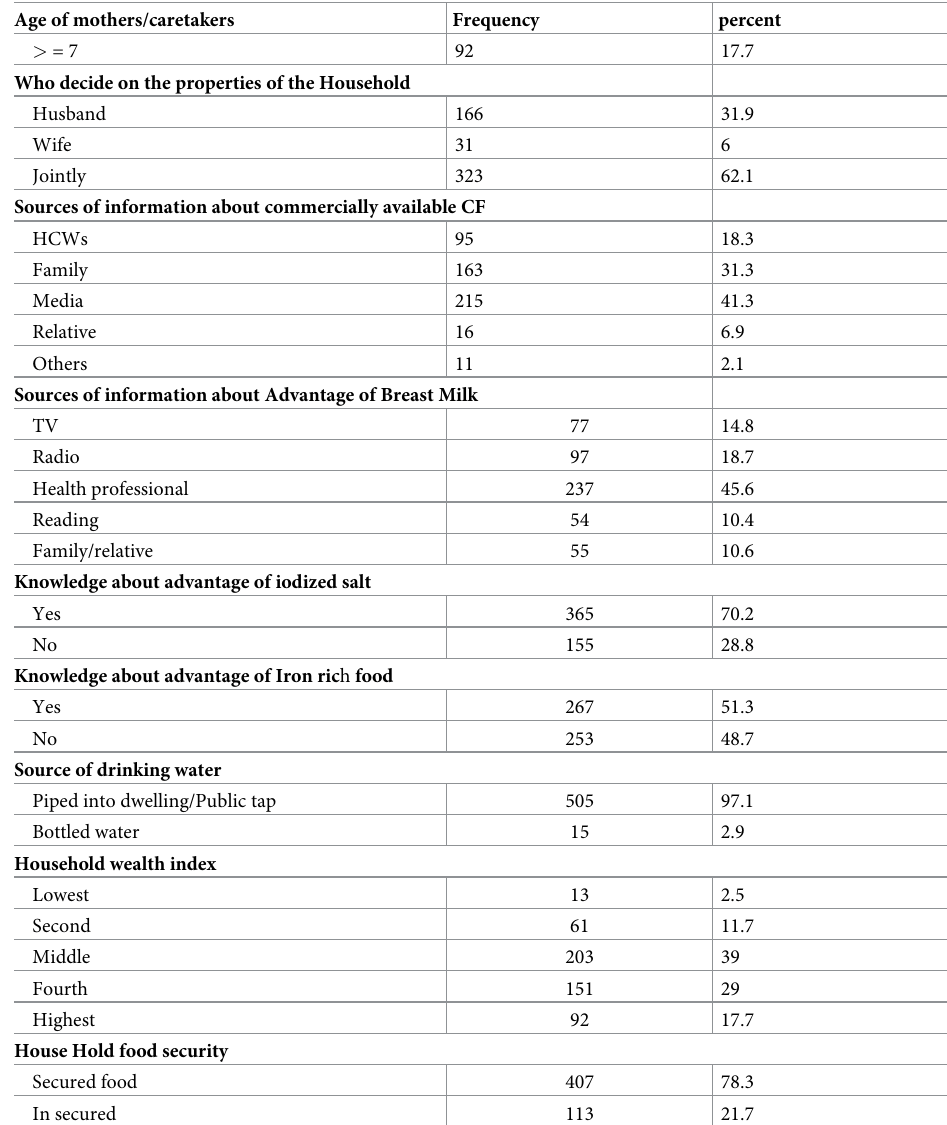
Thirty-one (6%) mothers begin CF earlier. Mothers’ negative attitude toward the quan- tity of breast milk, failure to stay with the child, and a lack of knowledge about breast milk were the most common reasons for early initiation of CF. in Ethiopia, the median and mean duration of any BF are both 25 months. Fig 3 depicts the mothers’ BF status; the median duration of BF was 14 months. I.e. 243/520 (46.7%) lower than the EDHS, 2011 [Fig 3]. Indicator of breast feeding status among 6–23 month age children in Shashemene oromia, Ethiopia,